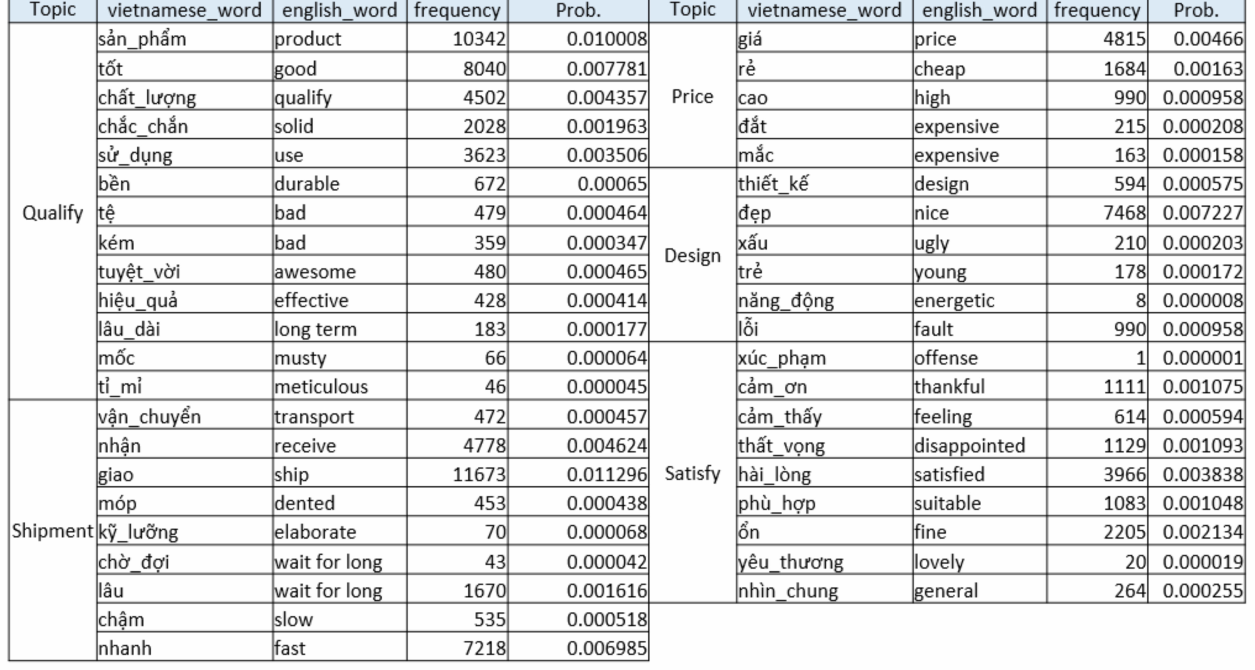
Figure 10. Topic